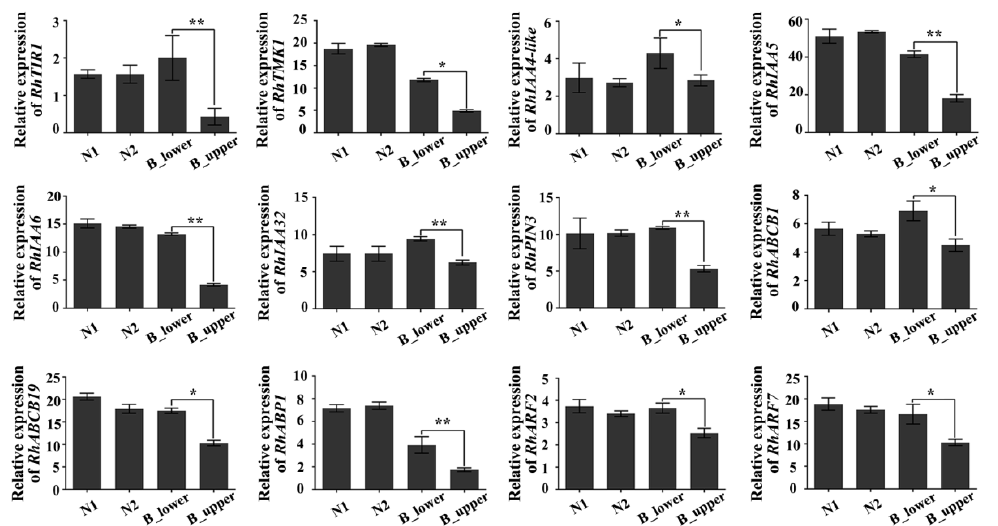
Figure 5. qRT-PCR of auxin-related genes in BP. Genes include those encoding auxin receptors ( RhTIR1 , RhTMK1 ), auxin-responsive factors ( RhIAA4-like , RhIAA5 , RhIAA6 , RhIAA32 ), auxin transporters ( RhPIN3 , RhABCB1 , RhABCB19 , RhABP1 ) and auxin-regulated factors ( RhARF2 , RhARF7 ). Error bars represent SD. Three biological replicates were performed. Asterisks denote statistically significant differences determined by using Student’s t -test (* p < 0.05, ** p < 0.01).